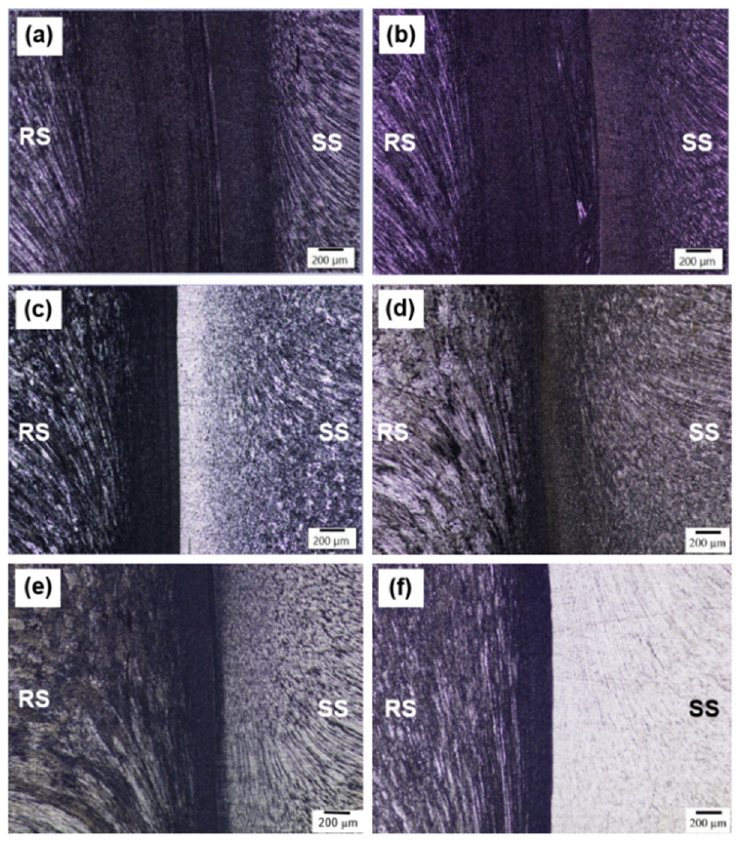
Figure 9. Microstructures of the dissimilar AA7075/AA5083 rotary friction welded joints near interfaces at: ( a ) 370 rpm, ( b ) 540 rpm, ( c ) 800 rpm, ( d ) 1200 rpm, ( e ) 1700 rpm and ( f ) 2500 rpm. Note: AA7075 and AA5083 are located as rotary side (RS) and stationary side (SS), respectively.